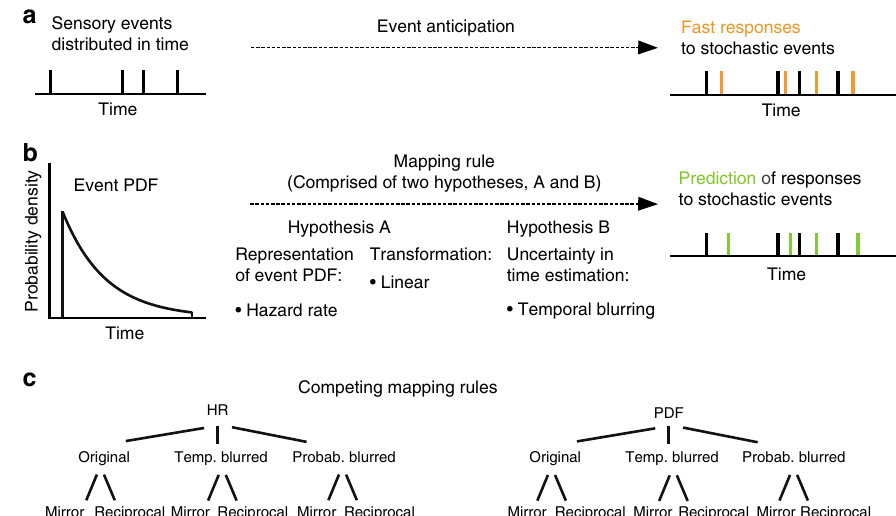
Fig. 1 Hypotheses and models of event anticipation. a Event anticipation facilitates fast responses to stochastic sensory events. b A mapping rule generates a prediction of reaction time (RT) based on the probability density function (PDF) of events. Mapping rule constituents include a representation of event probability, a transformation function between event probability and RTs, and a model of uncertainty of time estimation. c Overview of variables for temporal anticipation derived from mapping rules. The canonical hazard rate (HR) model is based on three assumptions: (1) the brain employs the HR to anticipate events in time. (2) Time estimation contains uncertainty that scales linearly with elapsed time (temporal blurring). (3) RT to events and the HR are linearly anti-correlated (mirror). The three assumptions are investigated using additional, PDF-based variables incorporating probabilistic blurring and a non-linear, reciprocal relationship between RT and model (see